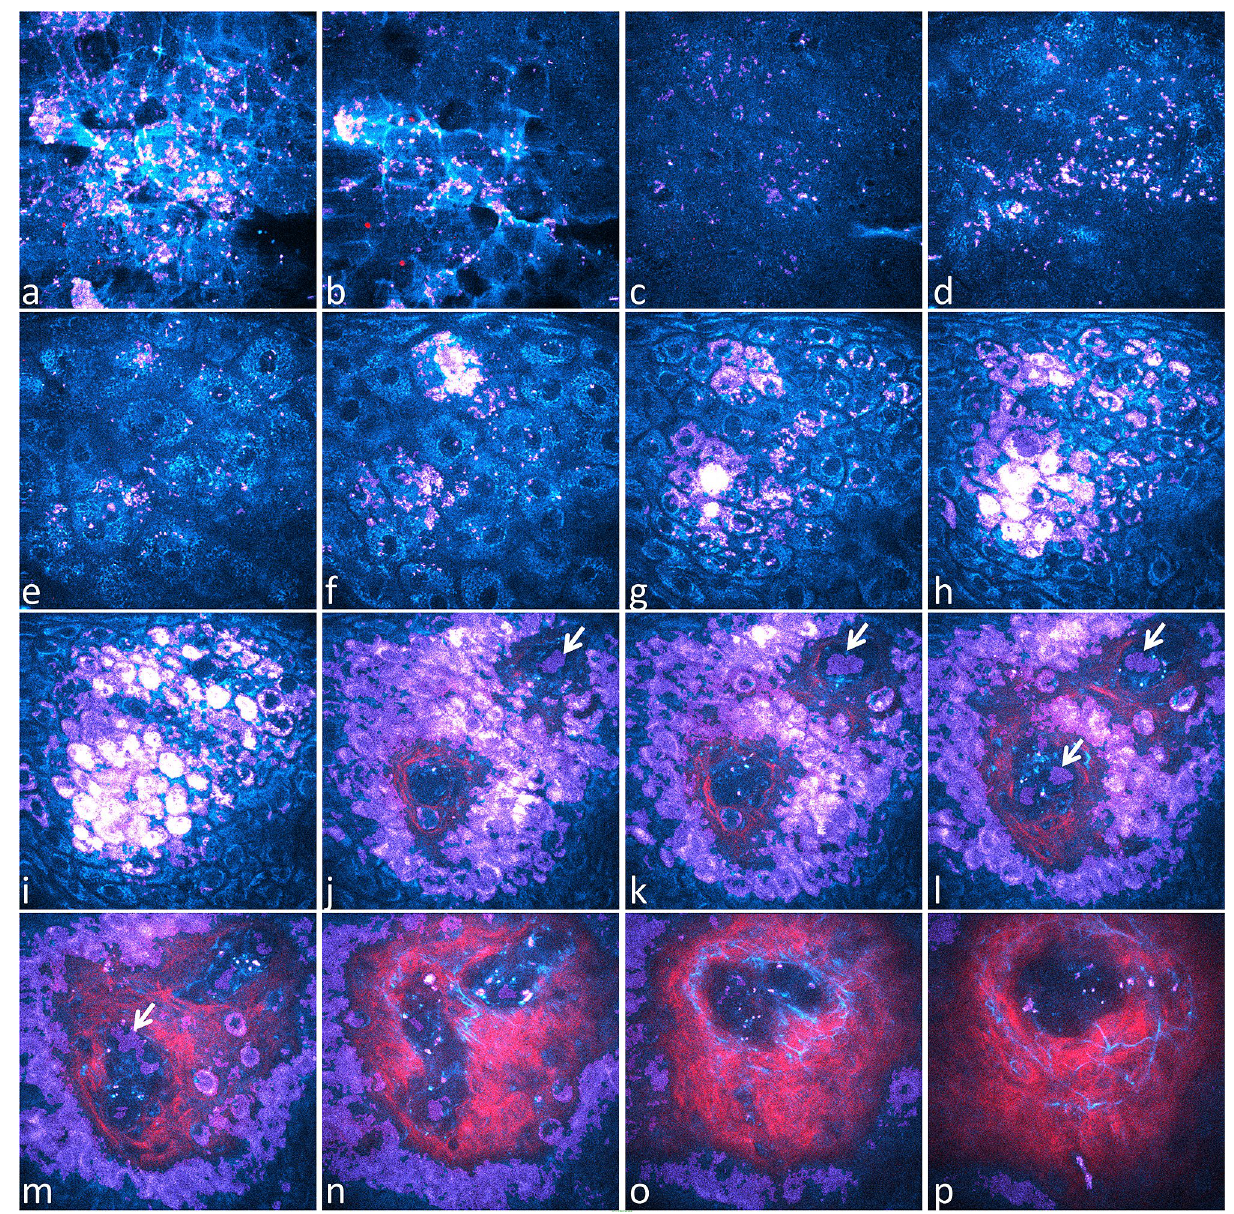
Figure 6. In vivo 3D multiphoton images of human skin – acquisition of combined 2PEF-FLIM (4 time channels)/SHG z-stacks compatible with Pseudo-FLIM melanin detection. 2PEF intensity is shown in cyan hot color, SHG in red and Pseudo-FLIM melanin mask pixels in purple. High 2PEF signal intensities appear in white color. Images are extracted from a z-stack of 70 en face images acquired with 2.346 µm z-step. ( a ) stratum corneum disjunctum ; ( b ) stratum corneum disjunctum/compactum interface; ( c , d ) compactum / granulosum interface; ( e , f ) stratum granulosum ; ( g , h ) stratum spinosum ; ( i ) stratum basale ; ( j – o ) stratum basale /dermis interface; ( p ) superficial dermis. Within the blood capillaries, Pseudo-FLIM detects cells with high slope values, fast decays, that most probably emit 2PEF signals from hemoglobin (see arrows). As the image acquisition time is slower than the blood flow, some blood cells appear with a deformed shape as indicated by the arrow in image on skin samples with variable constitutive pigmentation 9 . Although the correlations are strong, the link between skin color and melanin content is not necessarily linear: indeed, in group III, for the same measured color, the global melanin density is clearly higher in the subgroup of Asian origin (Fig. 7c). Such difference is not observed between Eu.O and As.O subjects in group II, possibly due to the very low density of melanin in light skin-type groups. Clear differences in global melanin density between Asian and European volunteers in groups III and IV (Fig. 7c) are associated with small ones for the L*, b* and ITA parameters (Fig. S5). The Asian volunteers have a slightly darker skin color and an increased b* value representing the blue–yellow component.